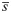
Top 10 emojis.Emojis are ordered by the number of occurrences N. The average position ranges from 0 (the beginning of the tweets) to 1 (the end of the tweets). p
c, c ∈ {−1, 0, +1}, are the negativity, neutrality, and positivity, respectively. s¯ is the sentiment score.